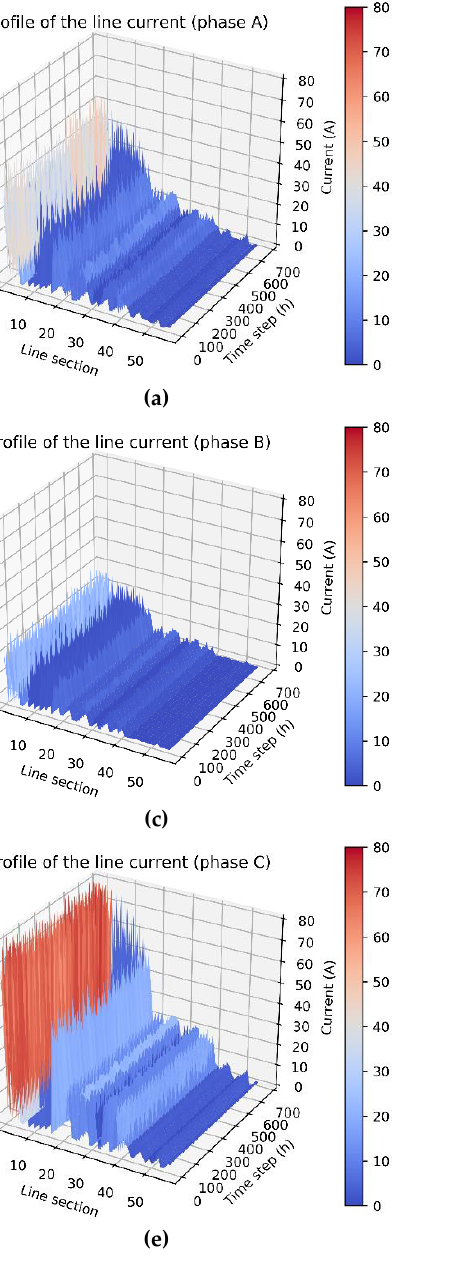
Figure 14. Line current profiles: ( a ) phase A: before rephasing, ( b ) phase A: after rephasing, ( c ) phase B: before rephasing, ( d ) phase B: after rephasing, ( e ) phase C: before rephasing, and ( f ) phase C: after rephasing.